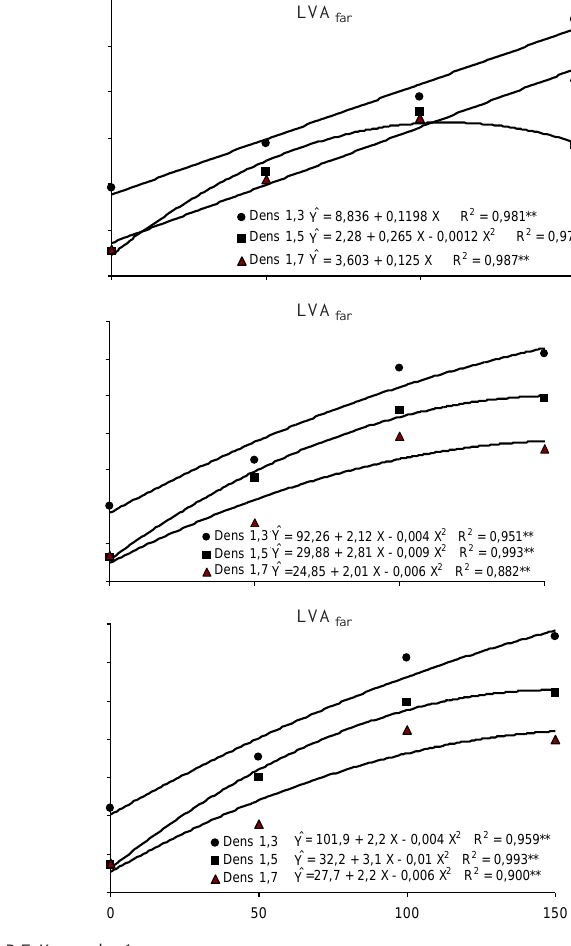
Figura 2. Conteúdo de K na raiz, parte aérea e total de plantas de E. camaldulensis , cultivadas em dois Latossolos de texturas muito argilosa (LV doses de potássio.